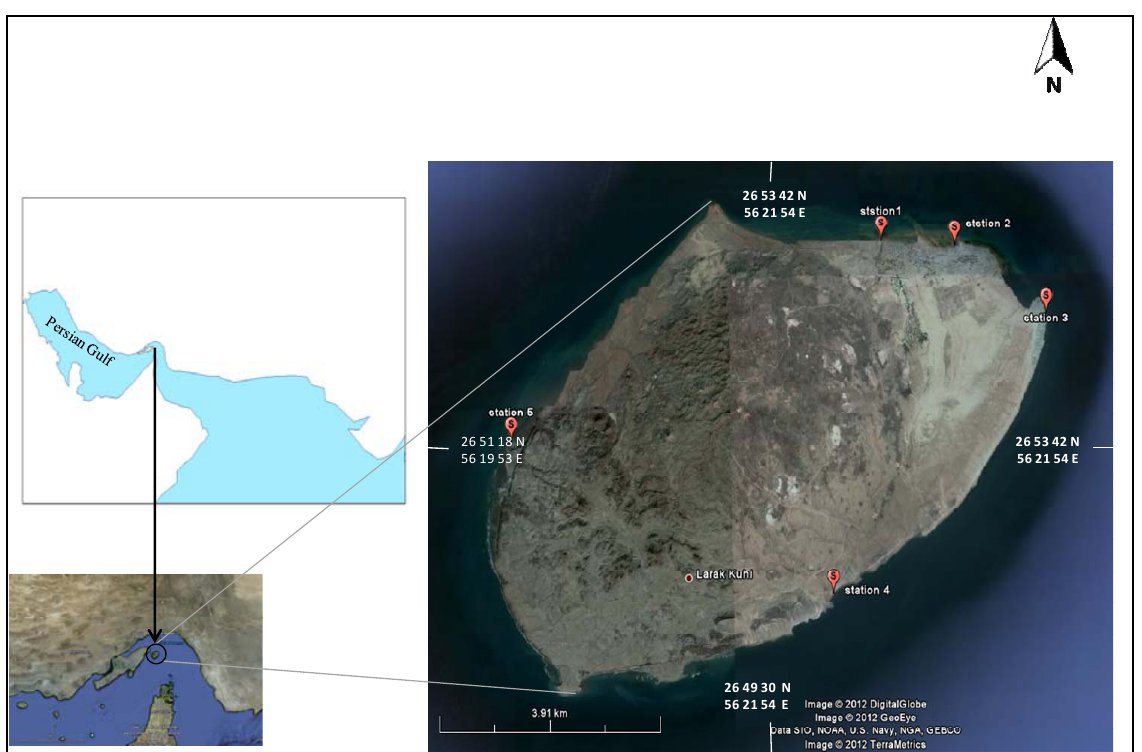
F IGURE 1. Sampling stations in the Larak Island (Persian Gulf,